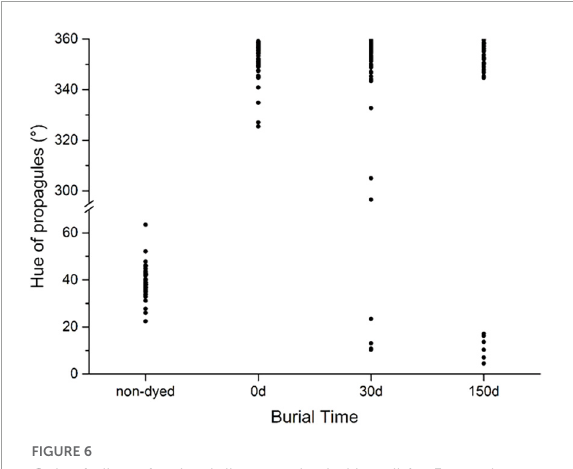
FIGURE6 Color fading of stained diaspores buried in soil for 5 months. The hue of stained diaspores between 300 and 360 ◦ (magenta to red) indicates the color keeps identifiable; otherwise, the color